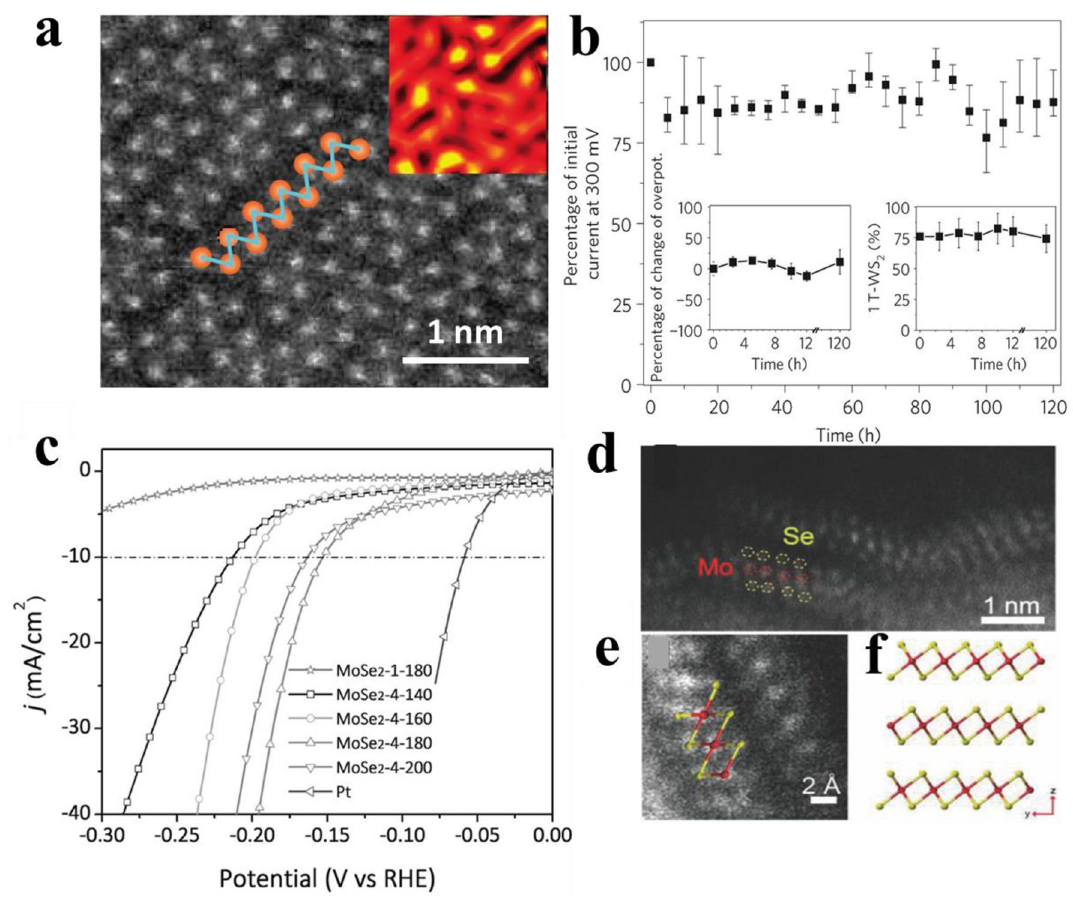
Fig. 5 a STEM image for the exfoliated WS (right) [63], c Polarization curves of various MoSe 2 and Pt samples 2 monolayer showing 1T superlattice. b The variation in current density as a function of time [64], d , e MoSe 2 nanosheet shell showing 1T-phase structure, f Crys- for 1T WS 2 electrode. The insets: the percentage of change in over- tal structure model of 1T-MoSe 2 potential (left) and variation in 1T phase concentration versus time